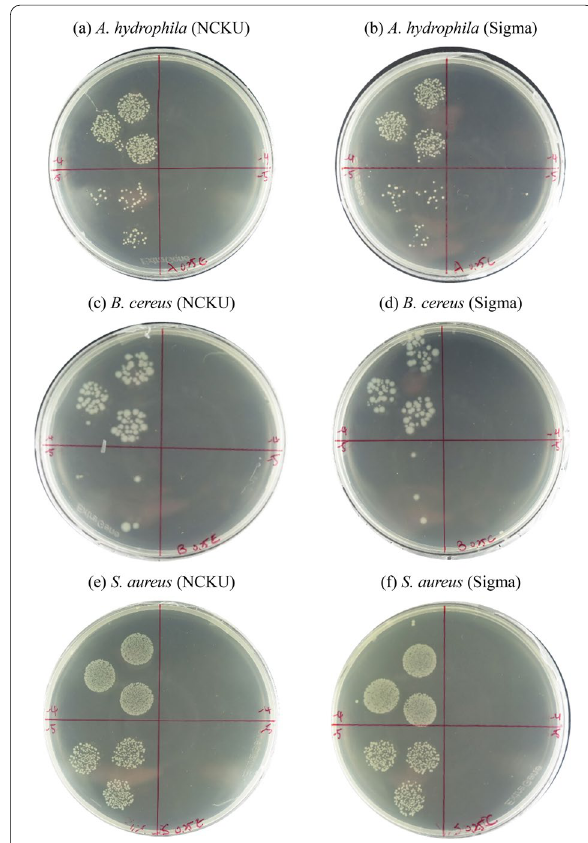
Fig. 5 The plate assay of aPDT using 5‑ALA from ( a , c , e ) purified (NCKU) and ( b , d , f ) commercial (Sigma A3785) against pathogen Aeromonas hydrophila ( a , b ) Bacillus cereus ( c , d ), Staphylococcus aureus ( e , f ). The left and right sides of plate represented control (without 5‑ALA) and experiment group (with 1% or 0.25%